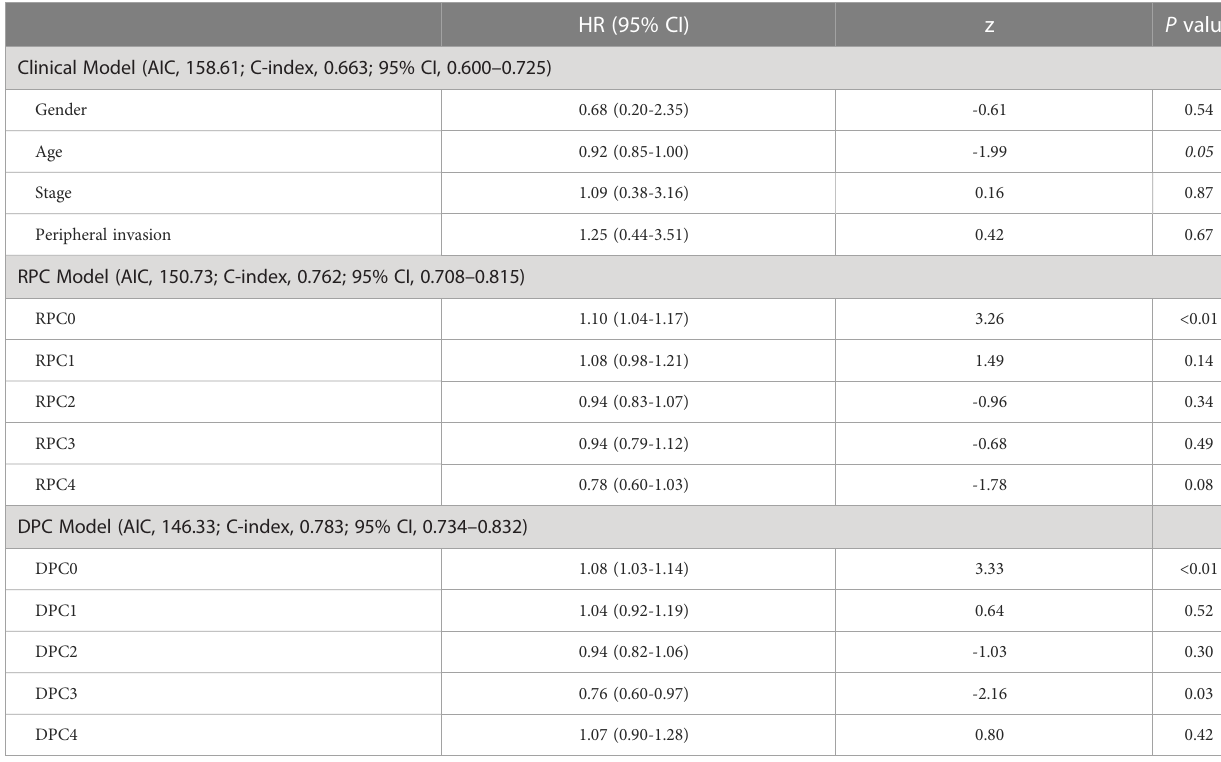
TABLE 2 Multivariate Cox Regression Analysis for the Clinical Model, Radiomic Principal Components (RPC) Model and Dosiomic Principal Components (DPC) Model respectively.